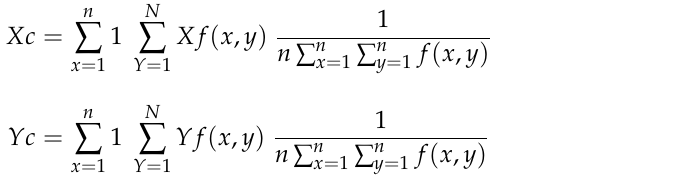
(a) Image Retrieval Pre-Processing: In the proposed algorithm, the image captured is required to find the region of interest in the image. The Region of Interest (ROI) with the centered method is used to determine the center of the images. Equations (6) and (7) can be used to calculate the center as